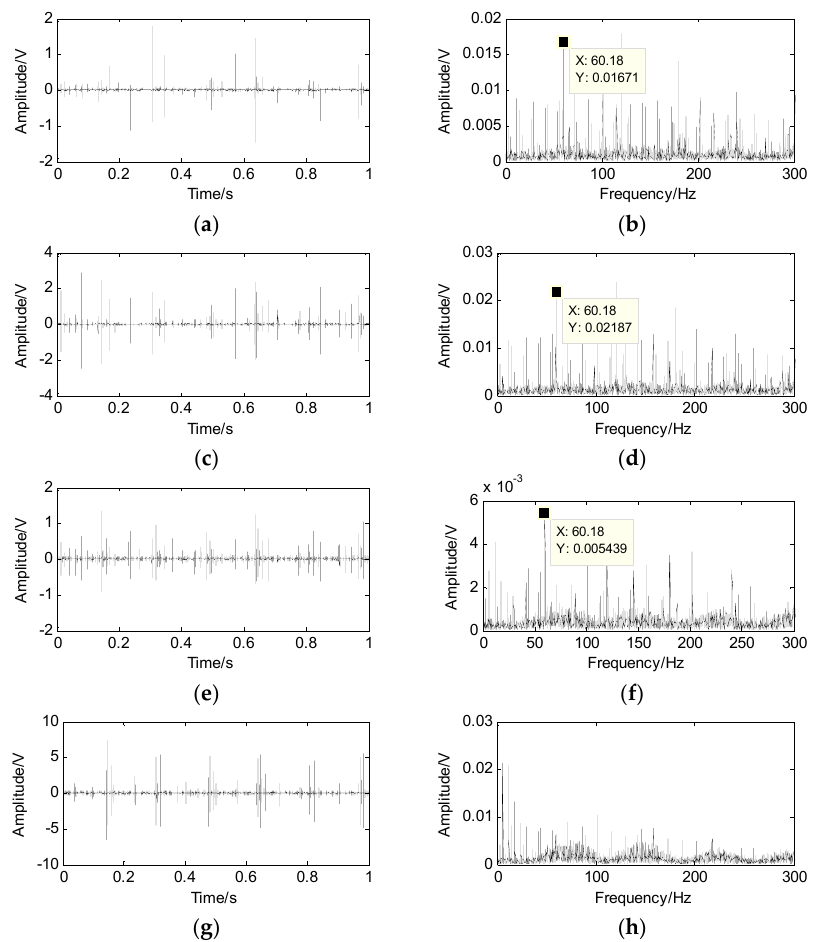
Figure 9. The wavelet modulus maxima of the first mixed signal and its spectrum. ( a ) wavelet modulus maxima of the first level; ( b ) the spectrum of the first level; ( c ) wavelet modulus maxima of the second level; ( d ) the spectrum of the second level; ( e ) wavelet modulus maxima of the third level; ( f ) the spectrum of the third level; ( g ) wavelet modulus maxima of the fourth level; ( h ) the spectrum of the fourth level.